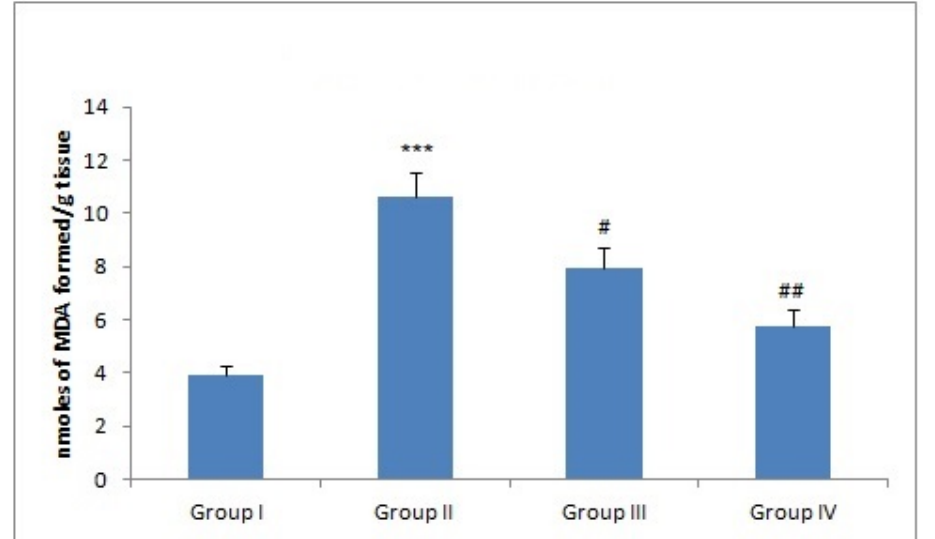
Figure 2. Effect of naringenin and doxorubicin treatment on malonyl aldehyde (MDA) levels. In Figure 2. E ff ect of naringenin and doxorubicin treatment on malonyl aldehyde (MDA) levels. Dox-treated group-II, the MDA level was increased significantly (*** P < 0.001) as compared to the In Dox-treated group-II, the MDA level was increased significantly (*** p < 0.001) as compared control group-I. Treatment with naringenin (50 and 100 mg/kg b. wt.) significantly attenuated MDA to the control group-I. Treatment with naringenin (50 and 100 mg / kg b. wt.) significantly attenuated levels in group III ( # P < 0.05) and group IV ( ### P < 0.01) as compared to group II. MDA levels in group III ( # p < 0.05) and group IV ( ### p < 0.01) as compared to group II.